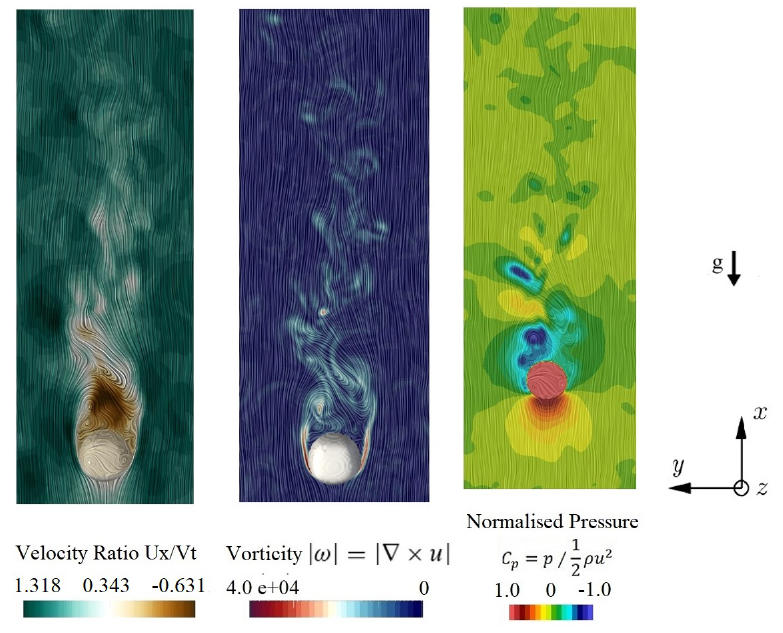
Figure 10. Instantaneous streamlines coloured with the normalised stream-wise velocity ( left ), the vorticity magnitude ( middle ) and the normalised pressure ( right ) for the case D3L050T10, at about 1.6